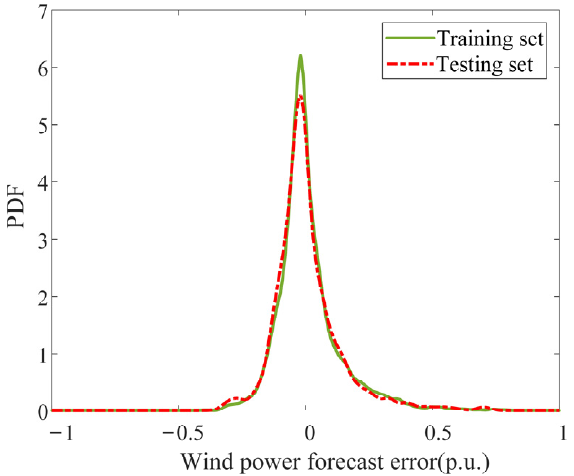
Figure 10. PDF curves of WPFE corresponding to mode 1 of season 1 in the initial training set and the initial testing set.